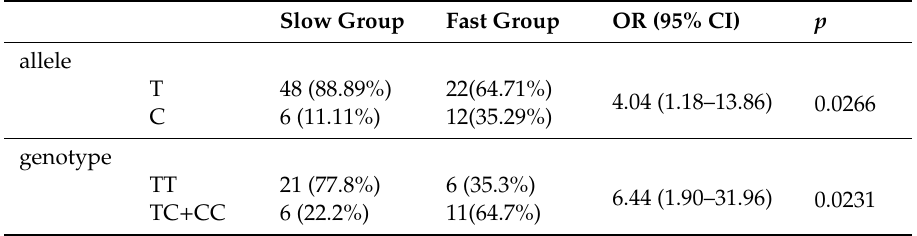
Table 3. Distribution of allele and genotype of rs2239359 in FANCA in the slow and fast groups. Slow Group Fast Group OR (95% CI)